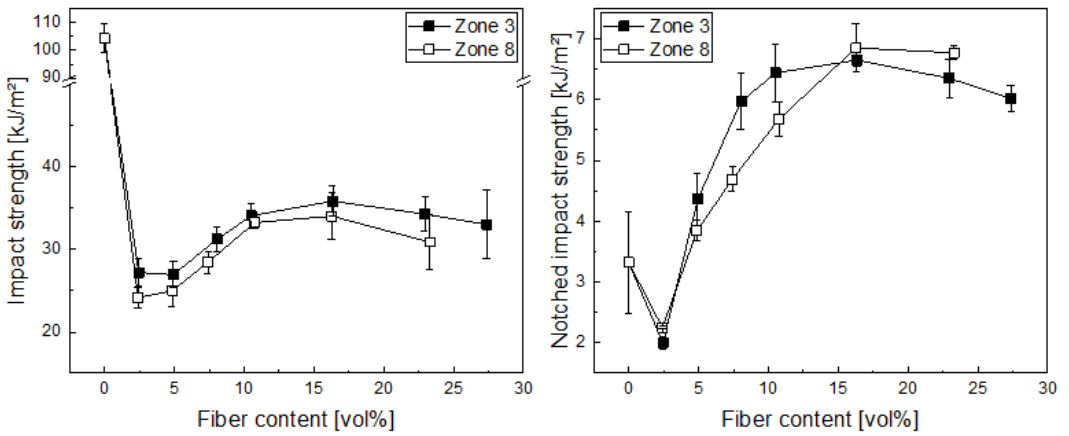
Figure 5. Unnotched ( left ) and notched ( right ) impact strength vs. the fiber volume content for carbon-fiber polypropylene composites produced with two different dosing positions in compounding (zone 3 and 8).